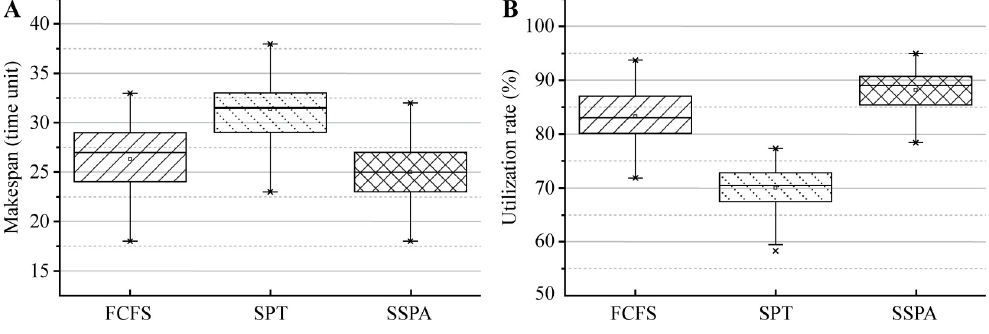
Fig 11. Box plots of FCFS, SPT, and SSPA in JSSP with ST. (a) Makespan and (b) utilization